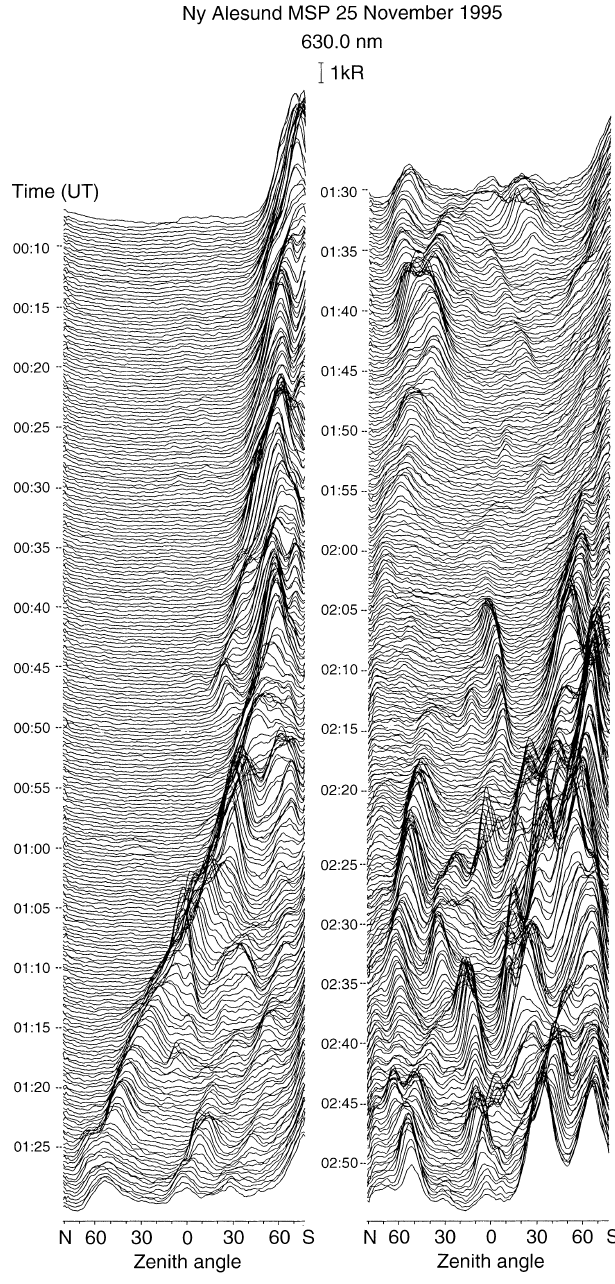
Fig. 2. The Ny A˚ lesund MSP red line (630 nm) emission observa- tions for the period 00 UT to 03 UT on 25